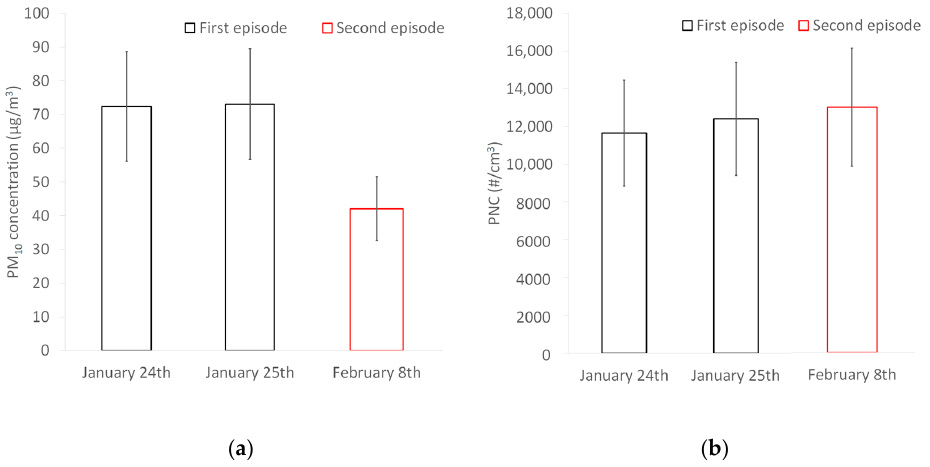
Figure 11. Daily averages during both episodes for ( a ) PM 10 mass concentration and ( b )